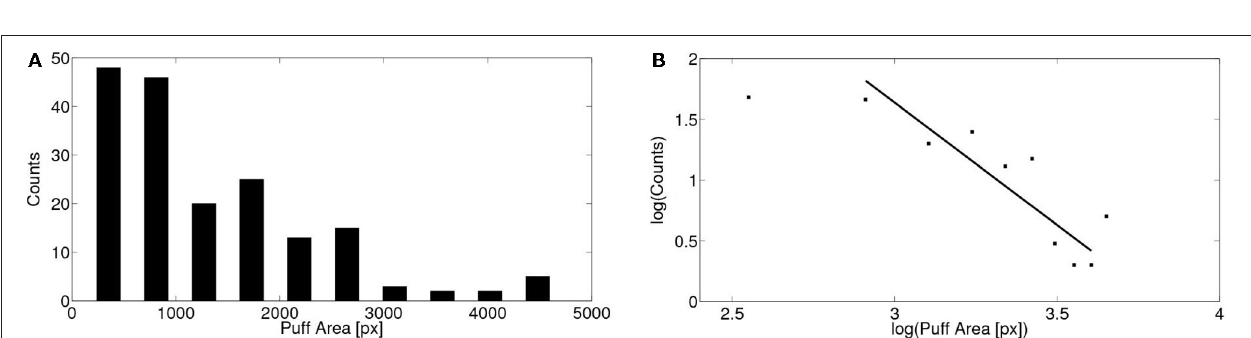
By fitting a power law relationship to some of the data points we obtain exponents between 1.8 and 2.0 with R 2 between 0.77 and 0.81 (if we include data between 800 and 4500 px or between 800 and 4000 px,